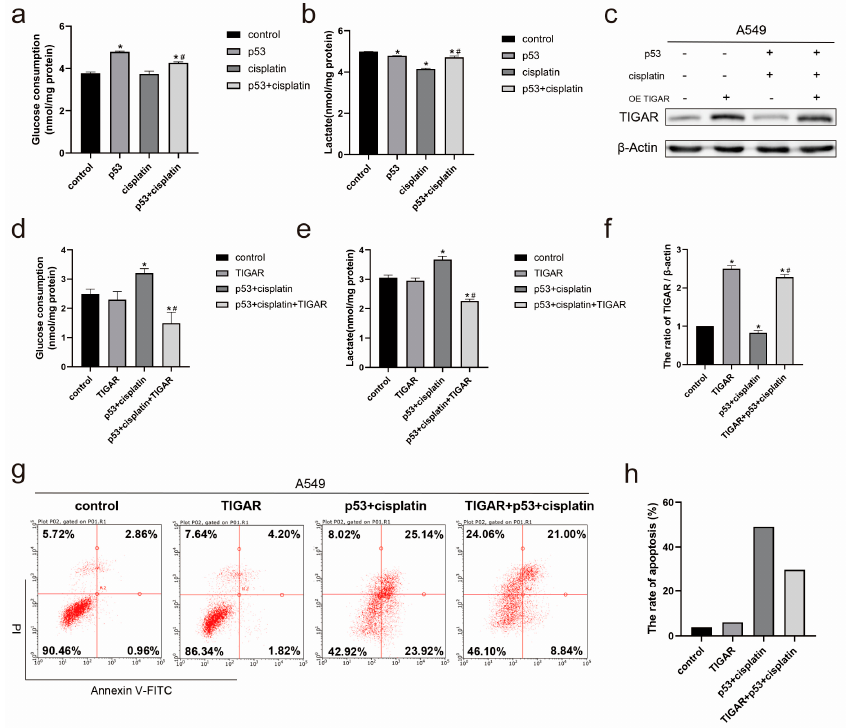
Figure 4. Combined treatment with p53 and cisplatin regulates the levels of glycolysis through TIGAR. ( a ) Glucose consumption and ( b ) lactate production were measured in the culture media from A549 cells transfected with p53 and/or subsequent exposure to cisplatin using glucose and lactate kit and normalized to the protein content. ( c ) Western blot was used to detect TIGAR protein expression in A549 cells. ( d ) Glucose consumption and ( e , f ) lactate production were measured in culture media from A549 cells transfected with TIGAR and combined p53 and cisplatin for 24h using glucose and lactate kit and normalized to the protein content. ( g , h ) Cell apoptosis was assessed by staining with Annexin V − FITC and PI in A549 cells transfected with TIGAR and combined p53 and cisplatin for 24h. Data are presented as mean ± SD, n = 3. * p < 0.05 vs. control and # p < 0.05 vs. cisplatin.